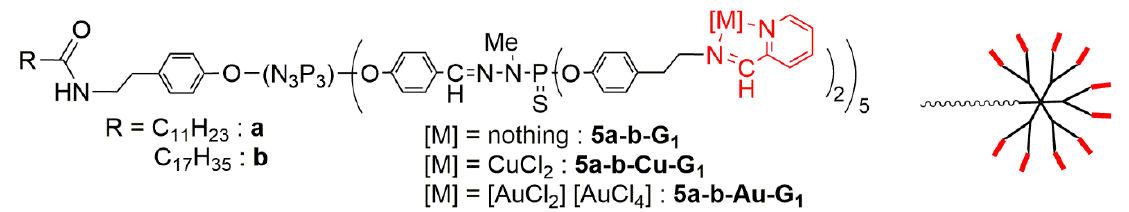
Figure 8. First generation off-center dendrimers bearing one alkyl chain at the core and 10 pyridine- Figure8. Firstgenerationo ff -centerdendrimersbearingonealkylchainatthecoreand10pyridine-imine imine ligands as terminal groups, either free or complexing copper or gold. ligands as terminal groups, either free or complexing copper or